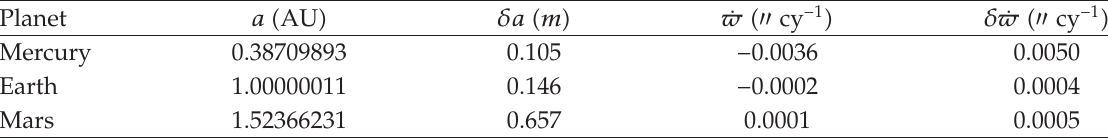
Table 1: Semimajor axes a , in AU (cid:5) 1 AU (cid:7) 1 . 49597870691 × 10 11 m (cid:6) , and phenomenologically estimated corrections to the Newtonian-Einsteinian perihelion rates, in arcseconds per century (cid:5) (cid:7)(cid:7) cy − 1 (cid:6) , of Mercury, the Earth, and Mars (cid:3) 10 (cid:4) . Also the associated errors are quoted: they are in m for a (cid:3) 11 (cid:4) and in (cid:7)(cid:7) cy − 1 for ˙ (cid:3) (cid:3) 10 (cid:4) . For the semimajor axes they are the formal, statistical ones, while for the perihelia they are realistic in the sense that they were obtained from comparison of many di ff erent solutions with di ff erent sets of parameters and observations (cid:5) Pitjeva, private communication 2005 (cid:6) . The results presented in the text